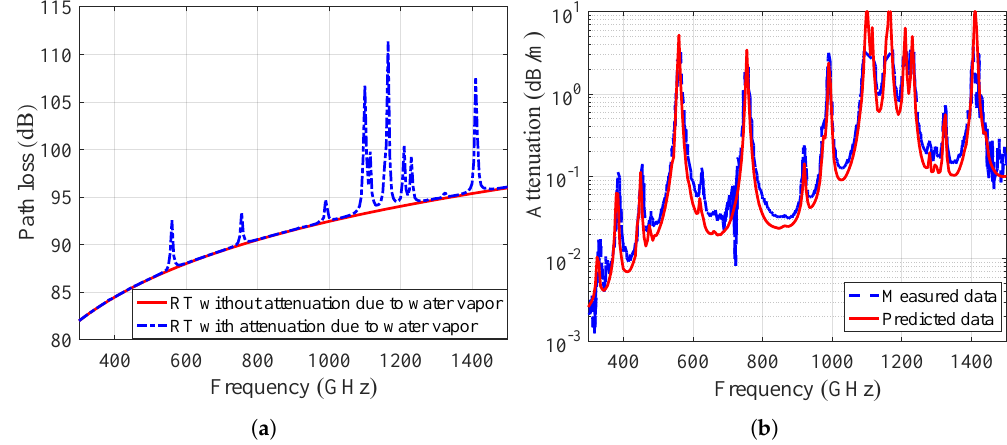
Figure 4. Validation of RT with attenuation for 70.84% relative humidity. ( a ) RT result vs. RT result with the attenuation for 70.84% relative humidity; ( b ) comparison between the measured (red) and predicted (blue) attenuation for 70.84% relative